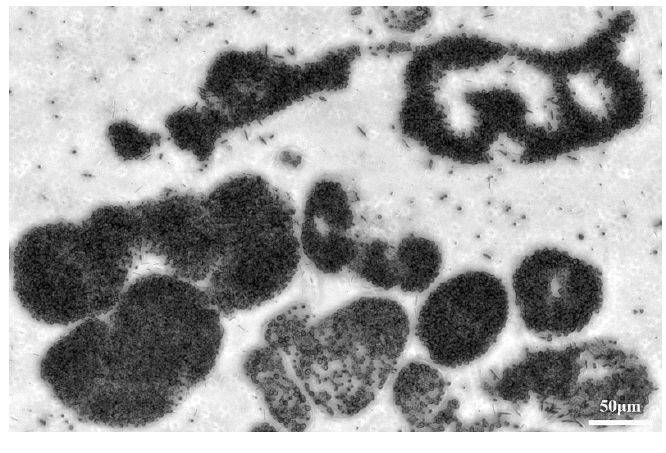
Figure 11. The micrograph of Microcystis cells.